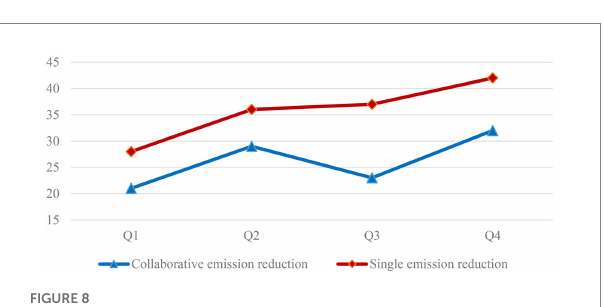
FIGURE 8 The carbon reduction in the different emission ways in the test